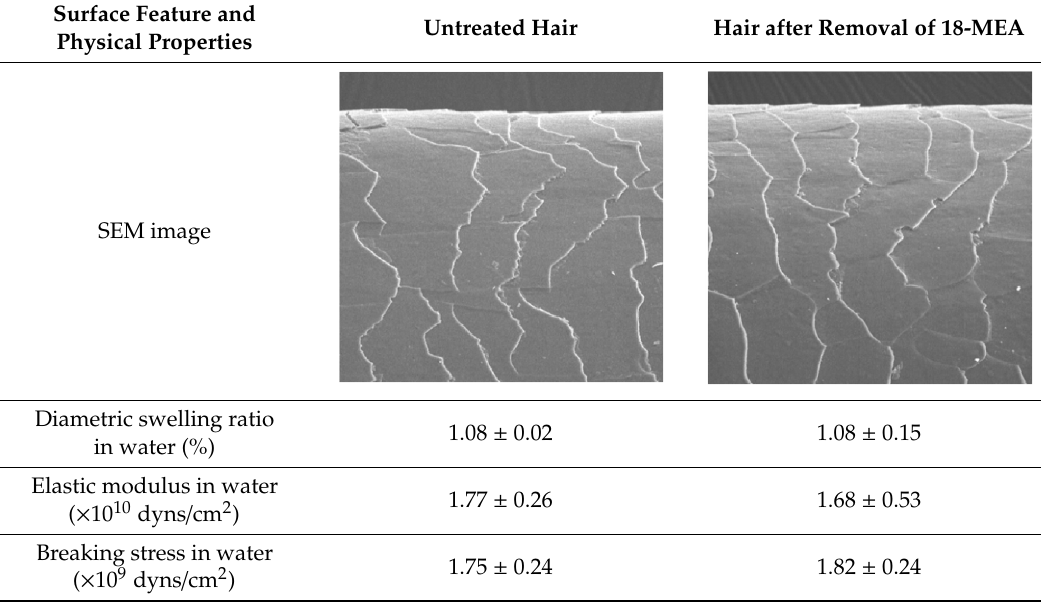
Table 6. Semi-quantitative amount of 18-MEA measured by TOF-SIMS and contact angles of hair. Amount of 18-MEA and Contact Angles